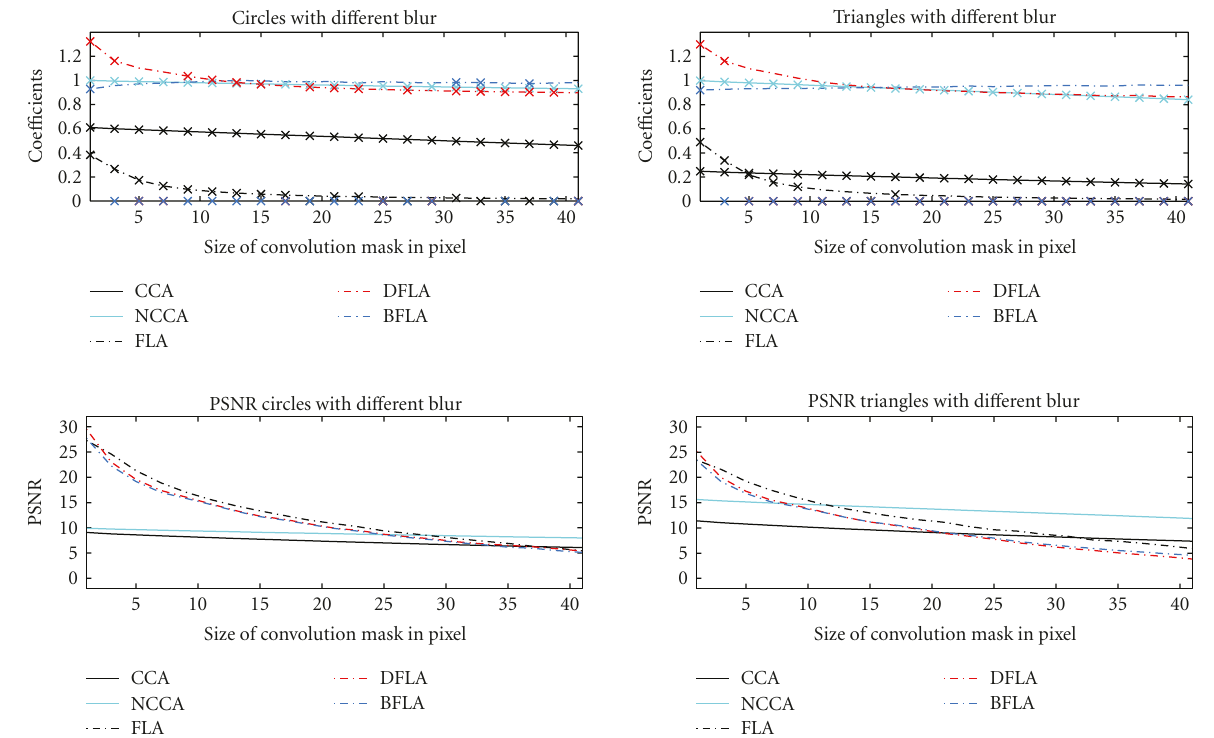
Figure 8: Influence of changing blur at the coe ffi cients and the PSNR of the cross-correlation algorithms. The blur is specified as the size of the convolution mask of the average filter in pixels. Top: coe ffi cients of the correlation algorithms, (marker—correct position found); bottom: PSNR of the correlation algorithms; left: results of the circles; right: results of the